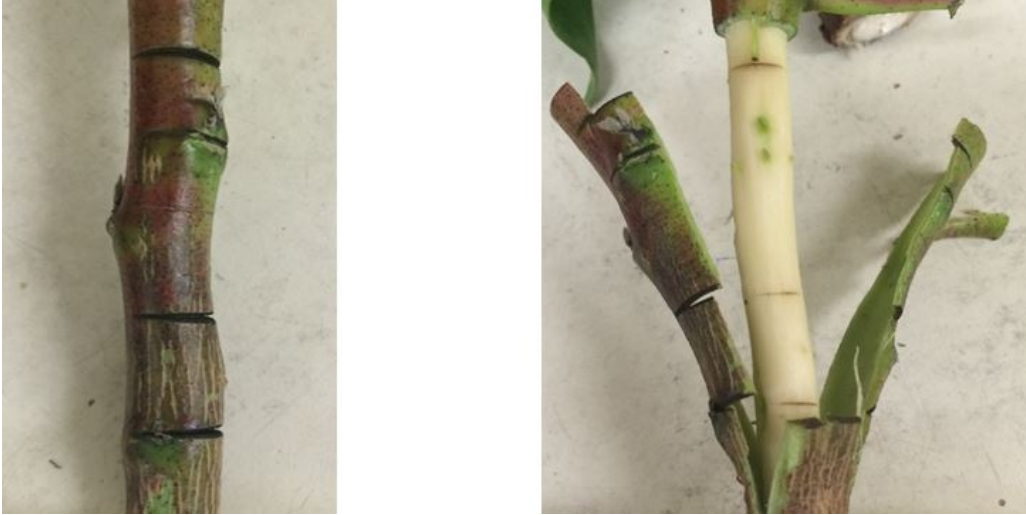
Figure 20. Figures details the results shown from laser power tests that were performed on freshly harvested field-grown cotton plants to determine cutting depth versus laser-power. The figure on left shows the stalk as it was immediately after laser cutting. The figure on right is after removal of the bark to reveal the depth of the laser cut. To ensure complete phloem termination, the white wood should show a laser scar all the way around the